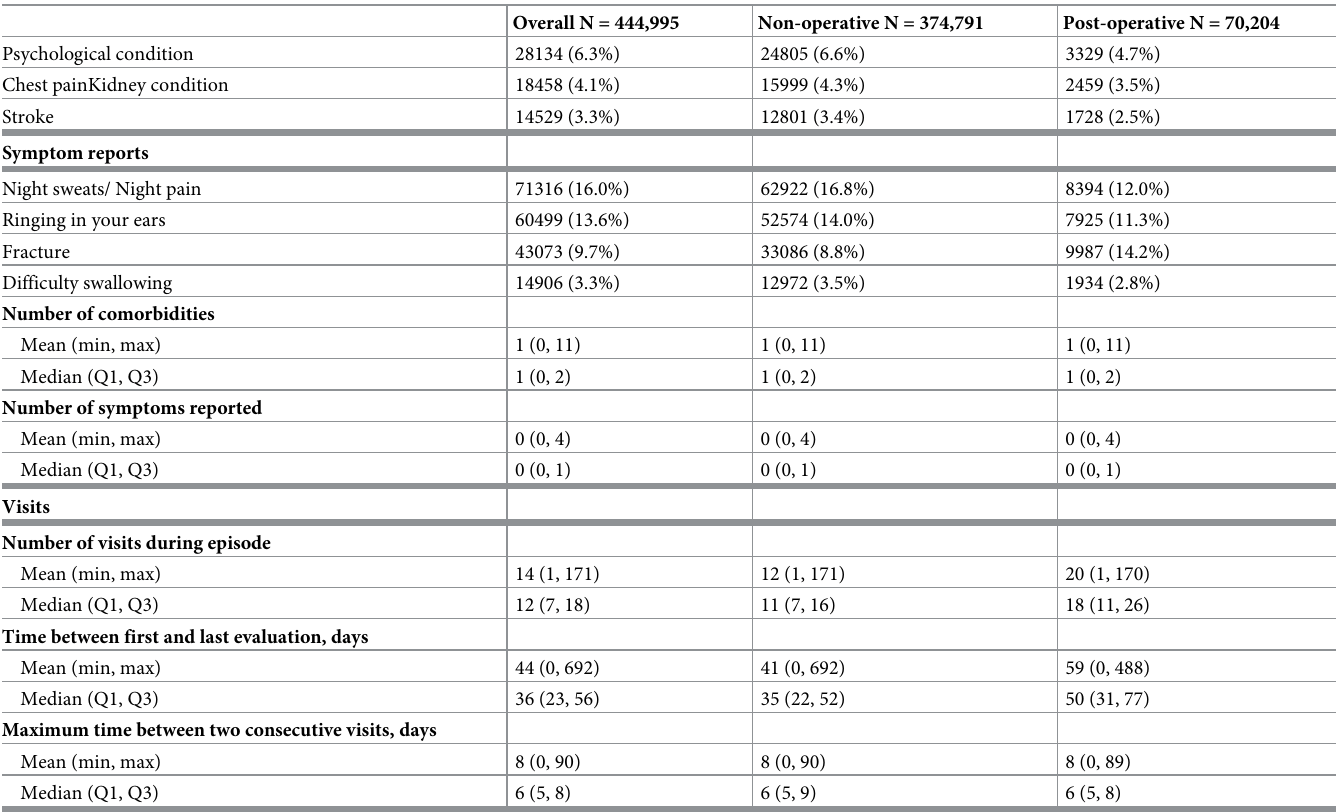
p < 0.001). As expected, operative care episodes were more likely to include patients with pri- mary body region of knee, foot/ankle, and shoulder and less likely to include patients with low back pain. Operative patients had a greater prevalence of high blood pressure, arthritis, and cancer at baseline compared to non-operative patients. However, there was no appreciable dif- ference in the number of reported medical comorbidities and symptoms reported between operative and non-operative patients.